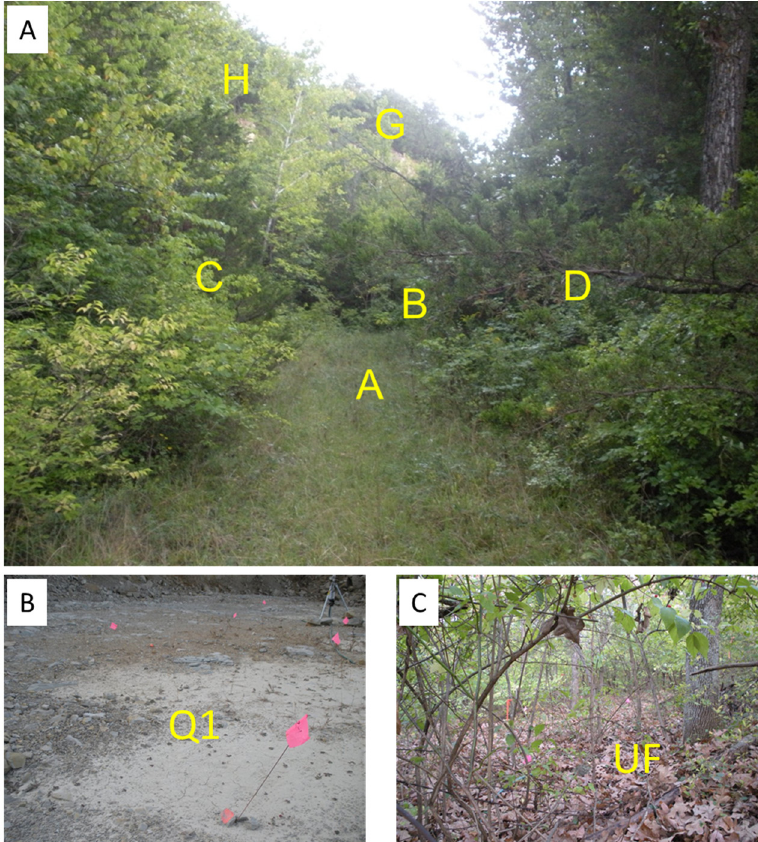
Figure 2. Photographs of study plots in ( A ) a quarry abandoned 70 years prior to the study (Q70), ( B ) a reference quarry that ceased operations 1 year prior to the study (Q1), and ( C ) an urban forest reference site that was never quarried and with trees over 100 years old (UF). Letters indicate approximate locations of study plots in Q70; plots A–D are on the quarry floor (Plot E is not visible), plots G and H are on the quarry top (Plot F is not visible). Plots Q1 and UF are in sites with the same respective names. Photos are directed south, north, and south for the three sites, respectively. The climate station is seen in Q1; pink flags indicate locations of sampling quadrats. All study sites are within city limits of Jefferson City, Missouri, USA.